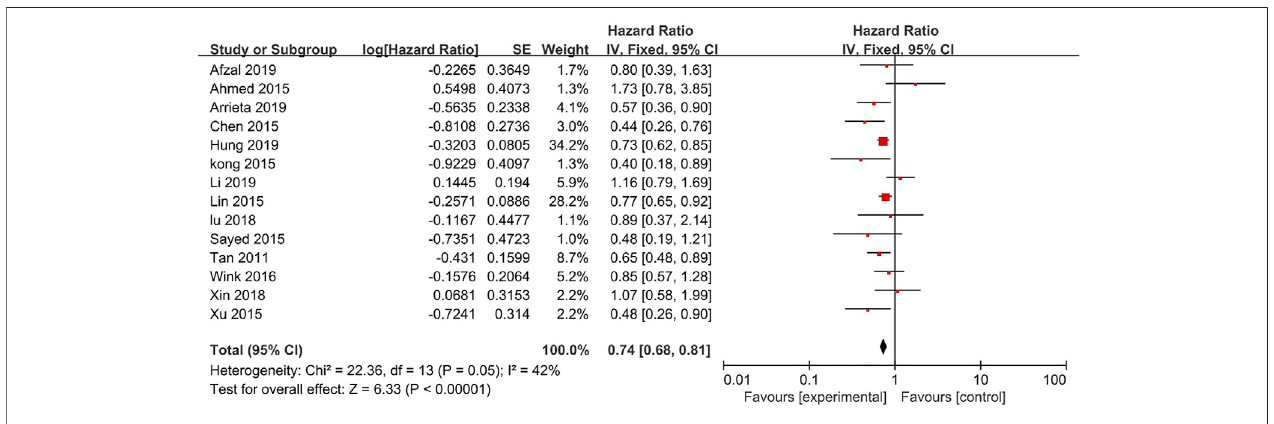
FIGURE 2 | Forest plot for the meta-analysis on overall